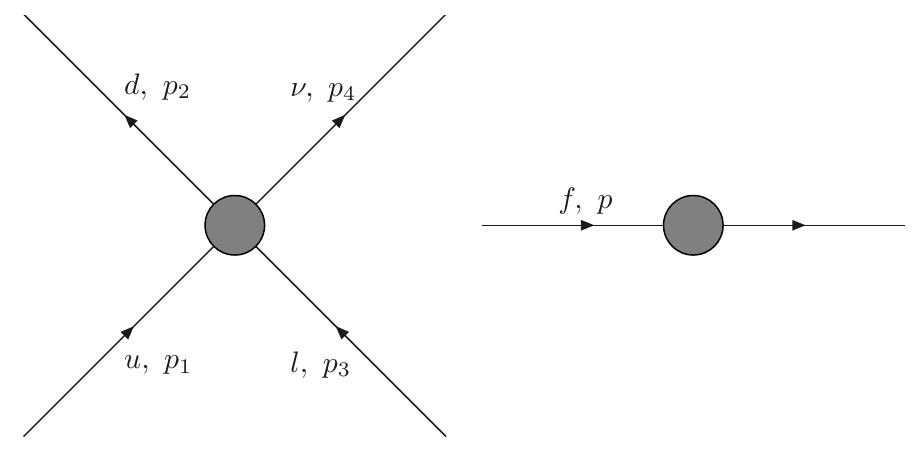
Figure 1. Kinematic conventions for the four- and two-point